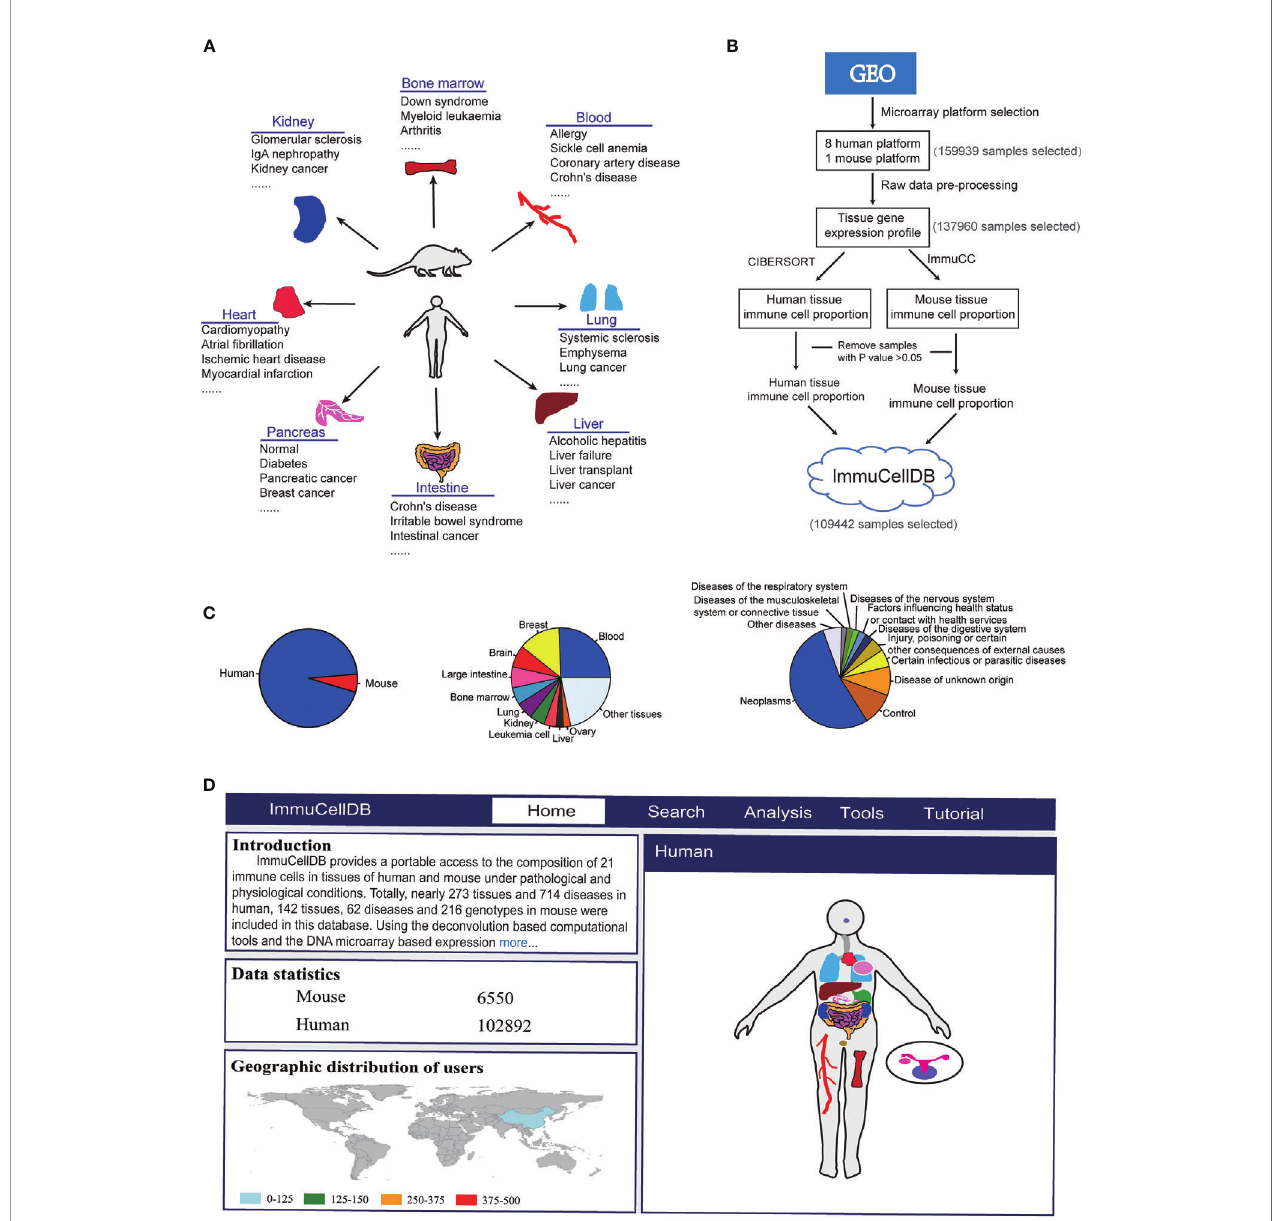
FIGURE 1 | Schematics for ImmuCellDB. (A) A brief introduction for the relationship of tissues and diseases in the database. (B) The work fl ow for the construction of database. Modules for data collection, data preprocessing, immune cell estimation and database construction are shown. (C) A pie plot for the relative proportion of species and top 10 most popular tissues and diseases. (D) A screenshot for the homepage of ImmuCellDB. The home page was consisted of four parts that is the introduction for the database, statistics of sample data, the worldwide distribution for all users to this database and a body map of human and mouse